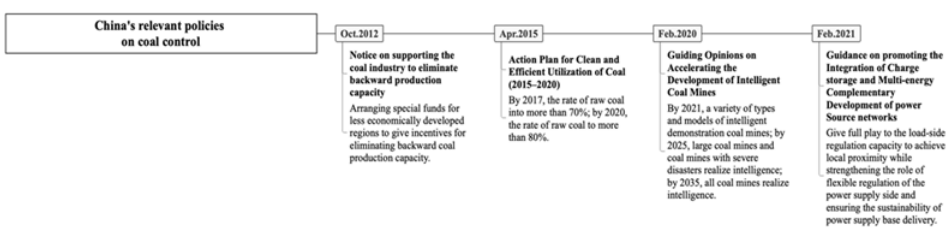
Figure 1. China’s relevant policies on coal